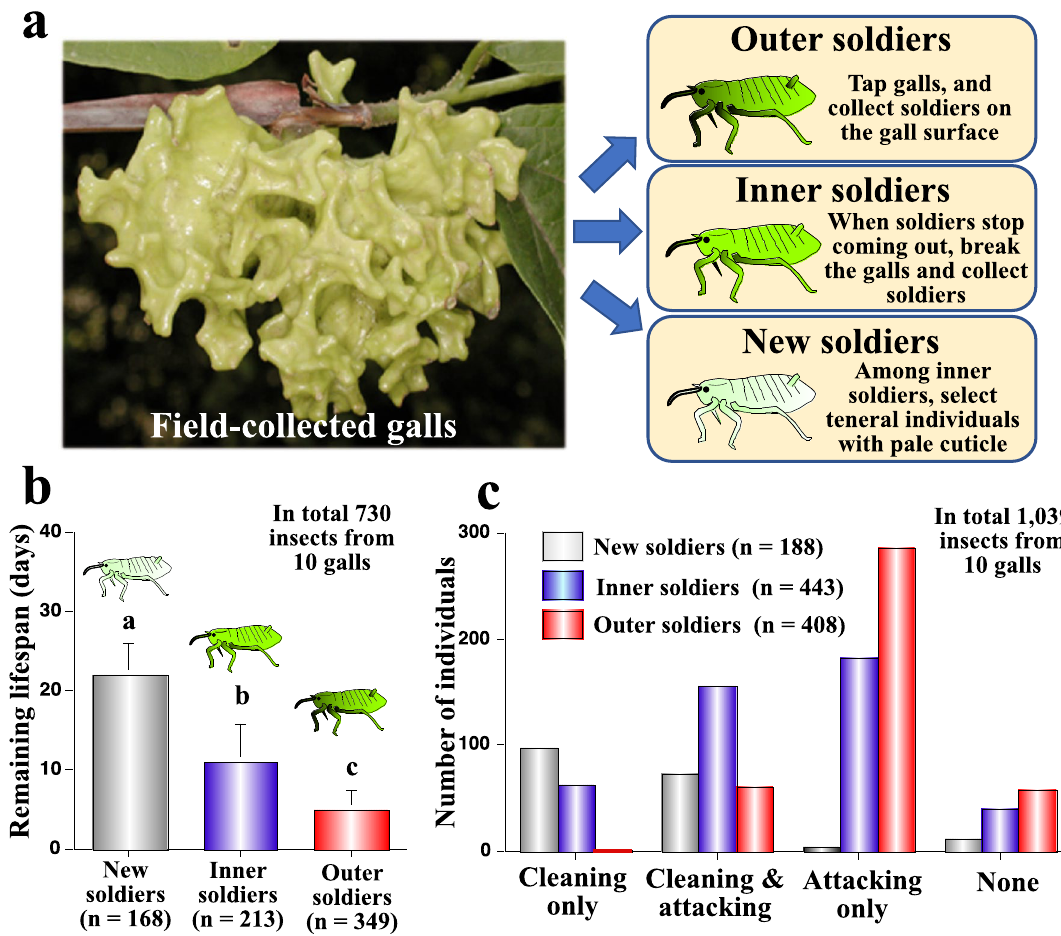
Figure 4. ( a ) A coral-shaped gall of T. styaci , and sampling procedures for outer soldiers, inner soldiers and new soldiers from field-collected galls. ( b ) Remaining life span of new soldiers, inner soldiers and outer